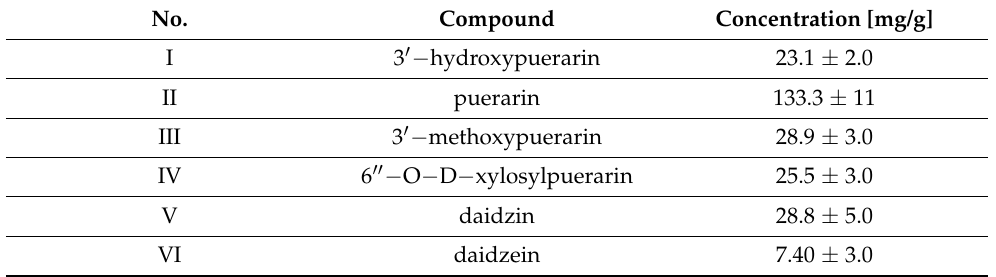
Table 1. Content of isoflavones in KU.